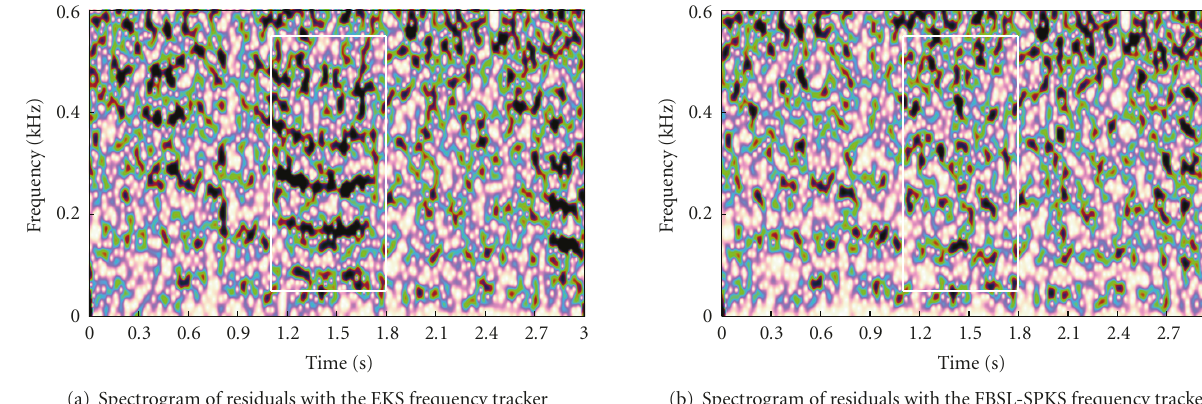
Figure 2: (a) EKS Estimation Error (NMSE = 8 . 56) and (b) FBSL-SPKS Estimation Error (NMSE = 7 . 53). The black area in the spectrograms represents great power concentrated in the corresponding frequency at a given time. If the harmonic tracking is successful, the black stripes in Figures 1(a) and 1(b) should be eliminated as shown in Figures 2(a) and 2(b). The EKS harmonic tracker does not track the harmonic components appropriately in the rectangular box in Figure 1(a), which results in the black stripes left in the box as shown in Figure 2(a).